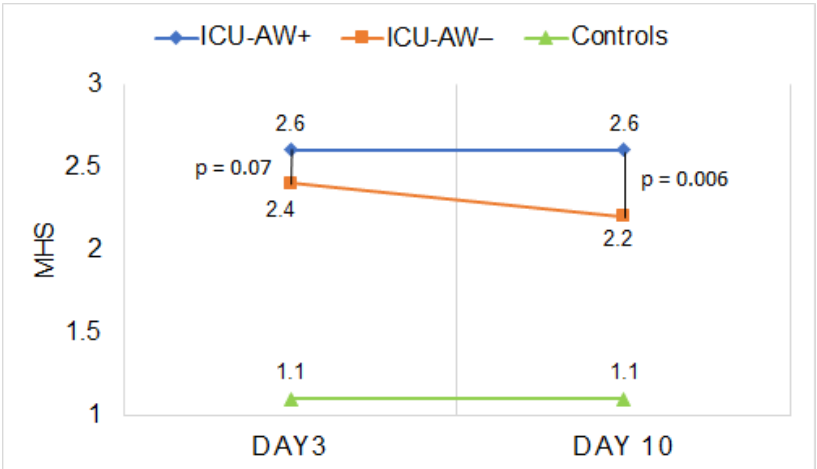
Figure 3. Longitudinal assessment of the MHS in ICU-AW+ patients, ICU-AW− patients and healthy controls on days 3 and 10. ICU-AW: intensive care unit-acquired weakness. ICU-AW+: patients with